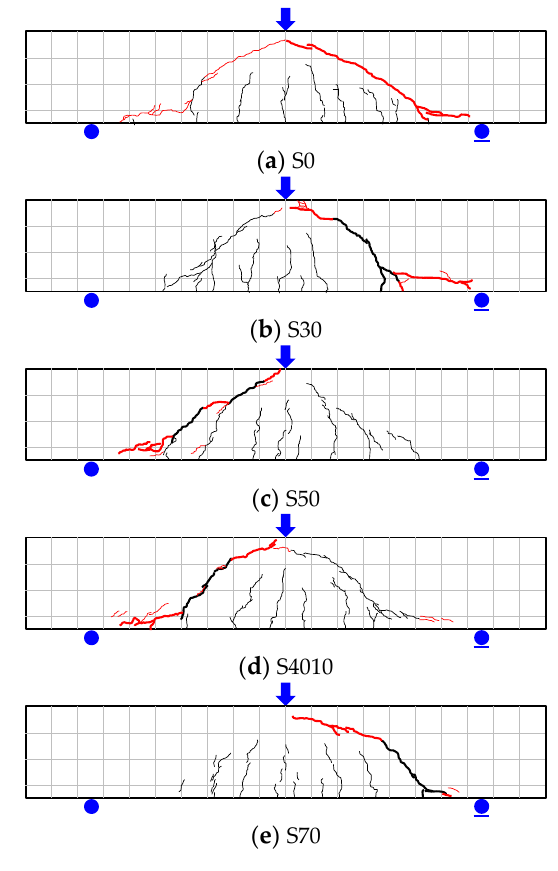
Figure 10. Crack patterns at failure of S series.